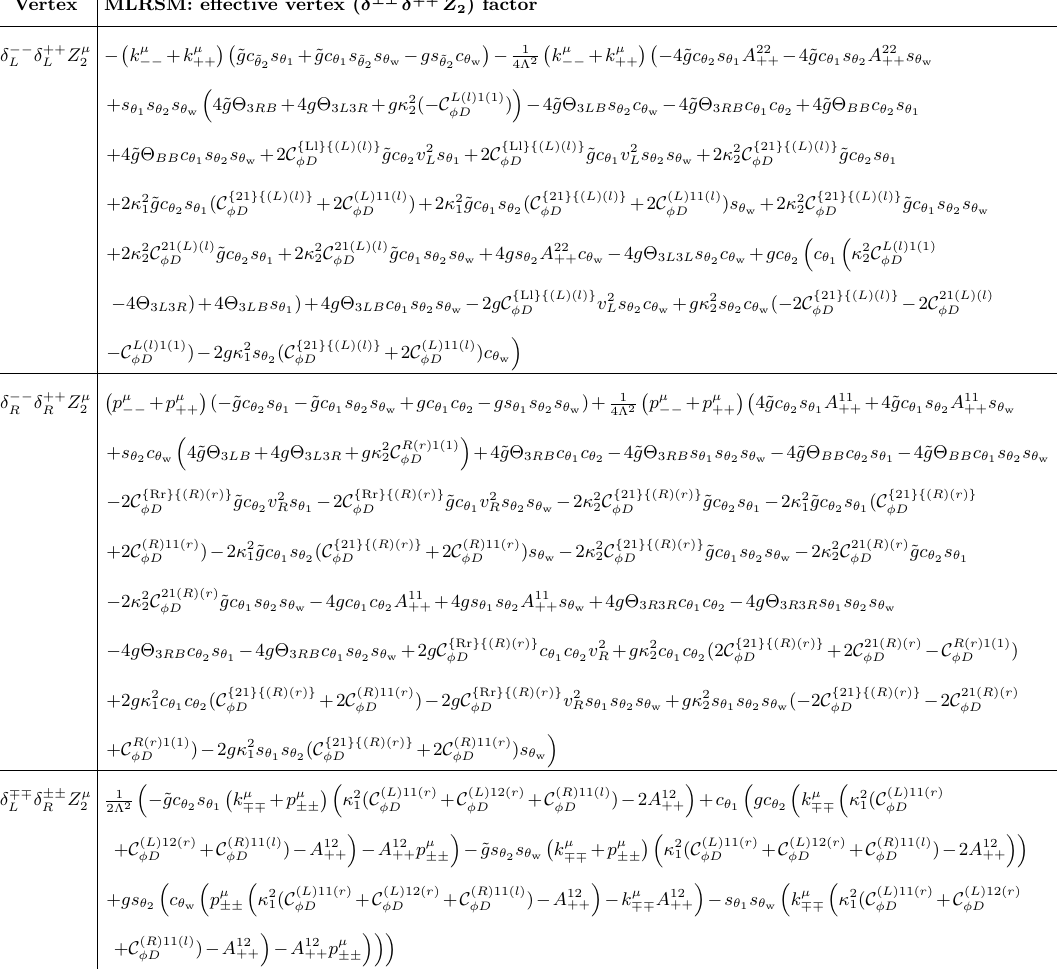
and (cid:14) (cid:6)(cid:6) L R